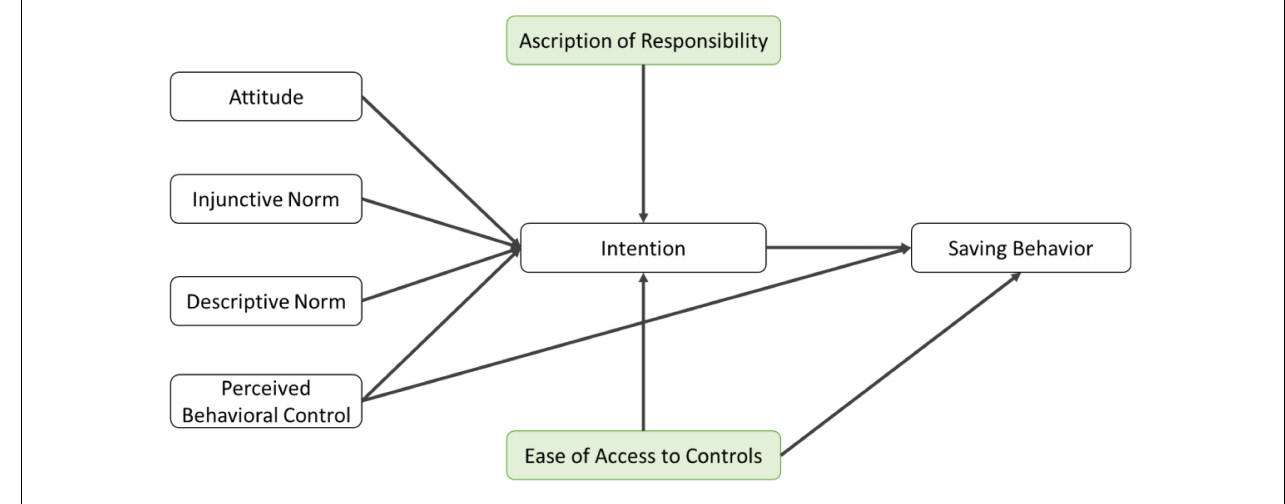
FIGURE 1 | The extended TPB model proposed in this